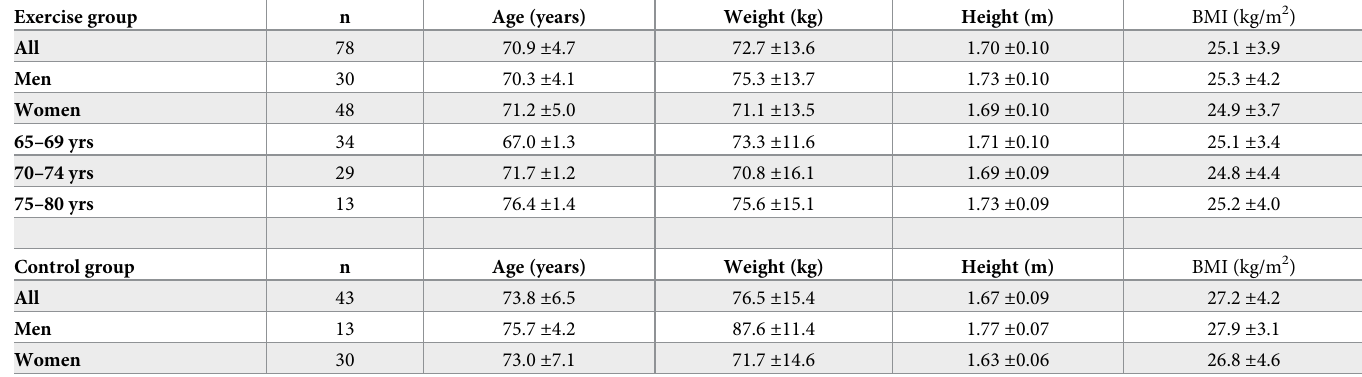
Table 1. Age and anthropometrics for the exercise group (n = 78) and the control group (n = 43) with mean values ± SD for age, weight, height and BMI for each group and for men and women separately. Exercise group values are also presented for each 5-year age interval, men and women together. Exercise